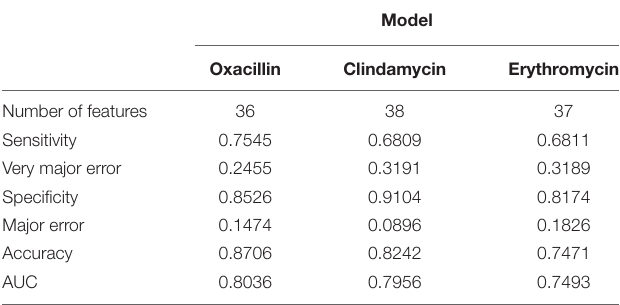
TABLE 3 | Performance of features selection on independent test